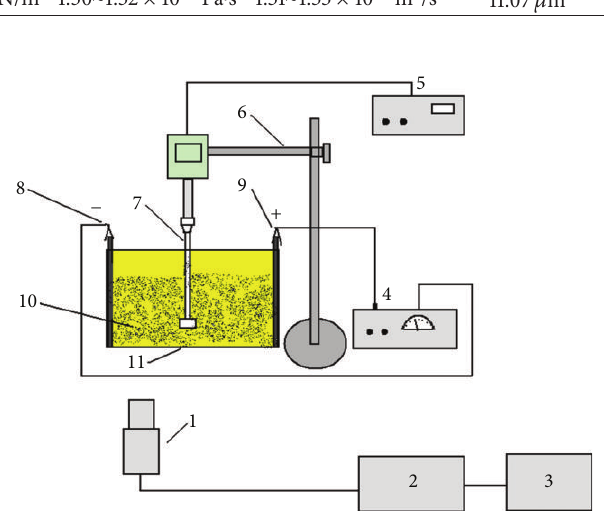
Figure 1: Experimental setup of electrodeposition ((1) camera, (2) image acquisition card, (3) computer, (4) electrodeposition device, (5) numerical control stirrer, (6) trestle, (7) stirring paddle, (8) negative electrode (iron), (9) positive electrode (zinc), (10) electrolyte, and (11) stirring